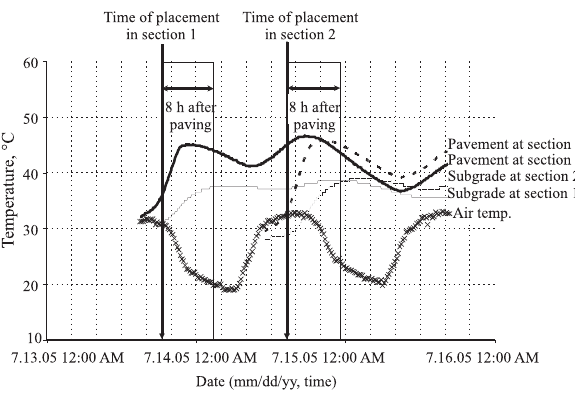
Fig. 2. Temperature variation with time during paving In-depth temperature distributions within 12 h